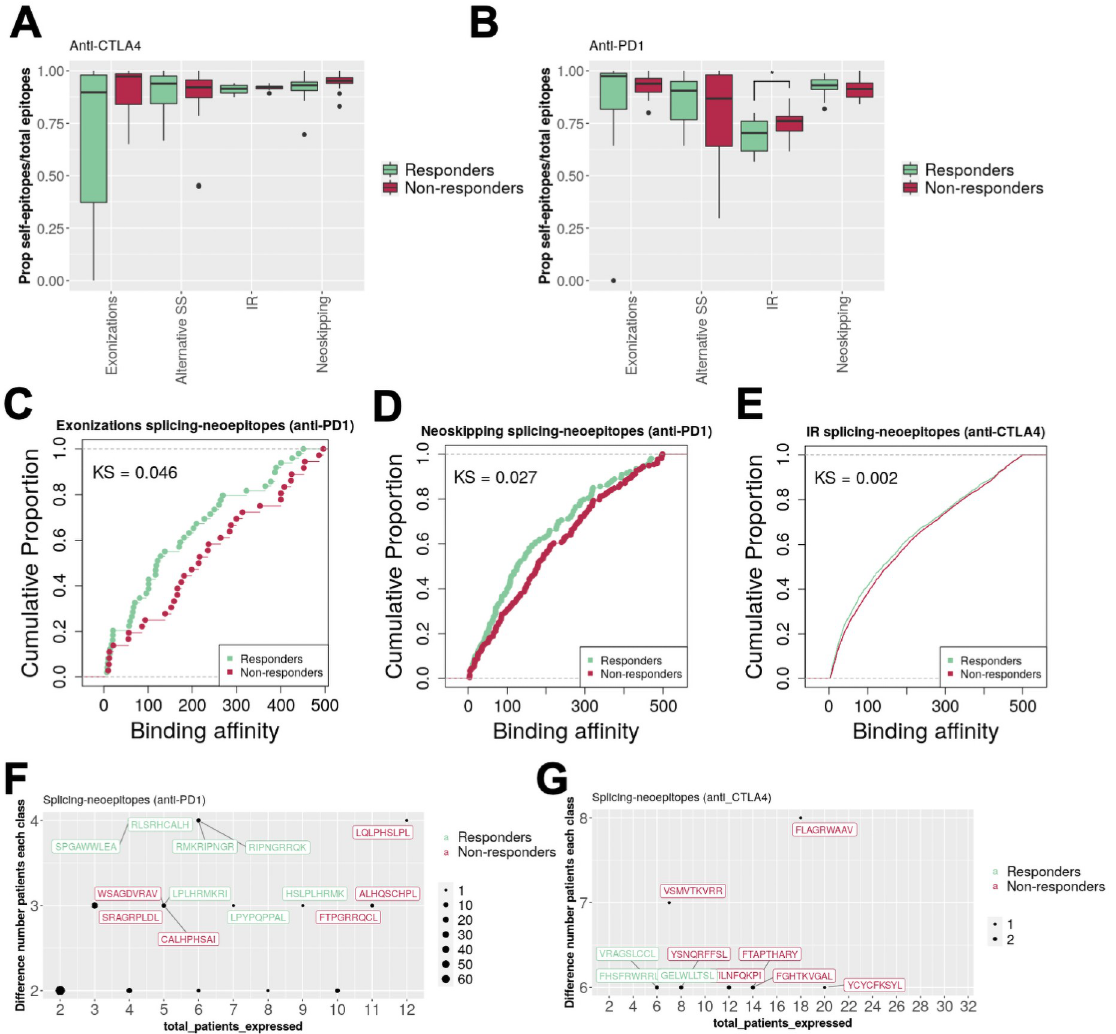
Fig 6. Splicing epitopes and response to immune therapy. (A) Proportion of splicing-affected self-epitopes (self-epitopes) over the total of epitopes, i.e., splicing-derived neoepitopes (splicing-neoepitopes) plus self-epitopes, (y axis) for patients treated with anti- CTLA4 , separated by type of splicing alteration (x axis) and by patient response: responder (green) or non-responder (red). (B) As in (A) but for a different cohort of melanoma patients treated with anti- PD1 . (C) Cumulative plots of the binding affinities (x axis) of splicing-neoepitopes in melanoma tumors from exonization events separated in responders (green) and non-responders (red) to anti-PD1 therapy. Kolmogorov- Smirnov test p-value (KS) = 0.0465 (D) As in (C), for splicing-derived neoepitopes from neoskipping events, KS = 0.0274. (E) Cumulative plots of the affinities of splicing-neoepitopes in melanoma tumors from intron retention events separated in responders (green) and non- responders (red) to anti-CTLA4 therapy, KS = 0.0016. (F) Frequency of splicing-neoepitopes represented according to the total number of patients in which are predicted (x axis, total_patients_expressed ) and to the absolute count-difference in responders and non-responders to anti- PD1 therapy (y axis, Difference number patients each class ). Epitopes are indicated in green if they are more frequent in responders, and in red otherwise. The size of the point indicates the number of cases. (G) The same as in (F) but for responders and non-responders to anti- CTLA4